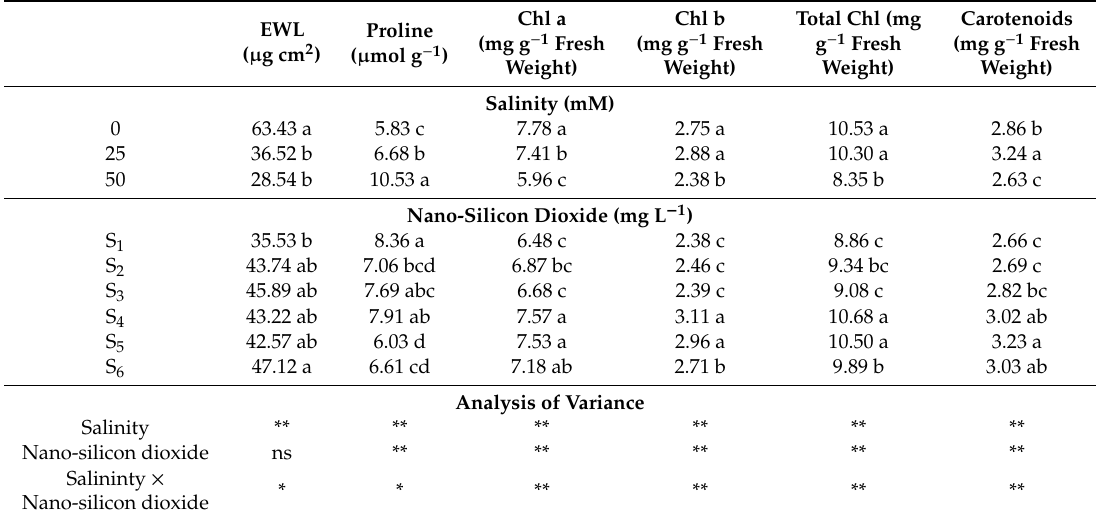
Table 5. E ff ect of nSiO2 and salt stress on Epicuticular Wax Layer (EWL), proline, chlorophyll (Chl a and Chl b and total) and carotenoids content of strawberry cv Camarosa under various conditions